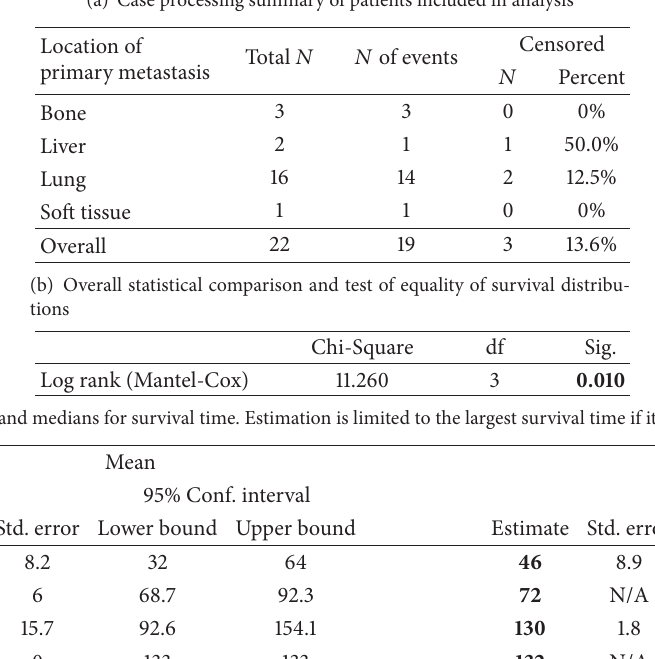
Table 6: Survival distribution among patients with metastasis stratified by location of metastatic disease. (a) Case processing summary of patients included in